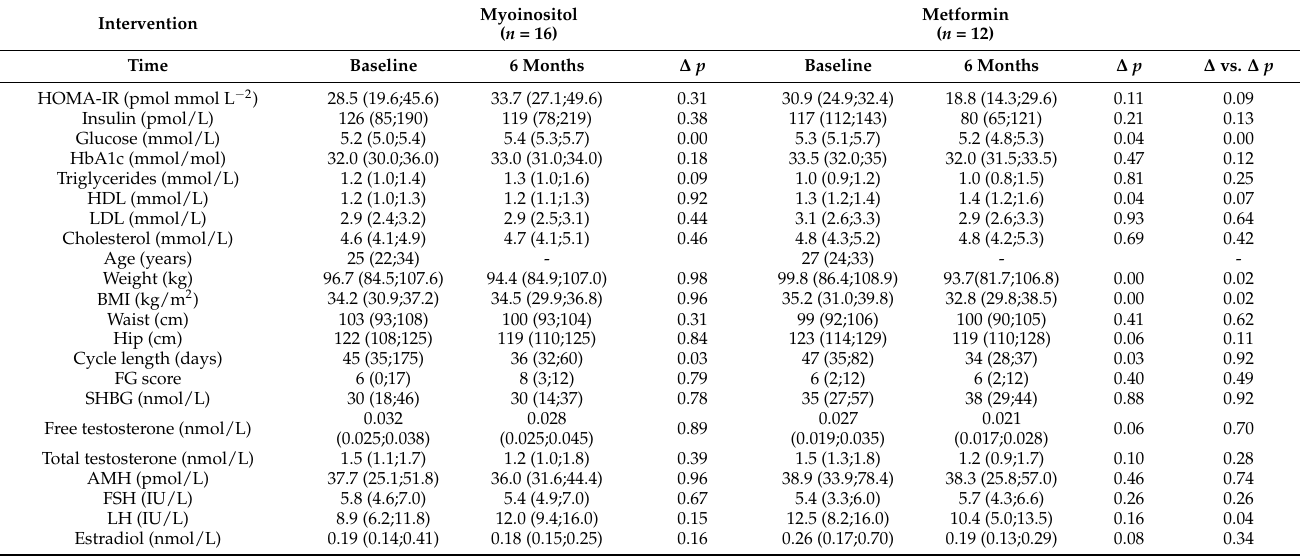
Table 1. Baseline characteristics and changes after 6 months in the myoinositol and metformin